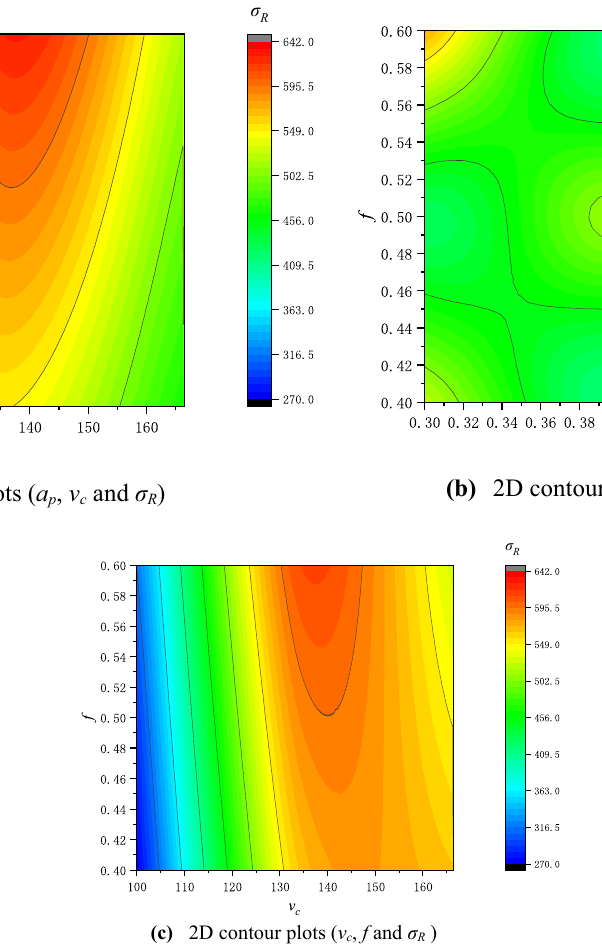
Figure 5. 2D contour plots of the process parameters.